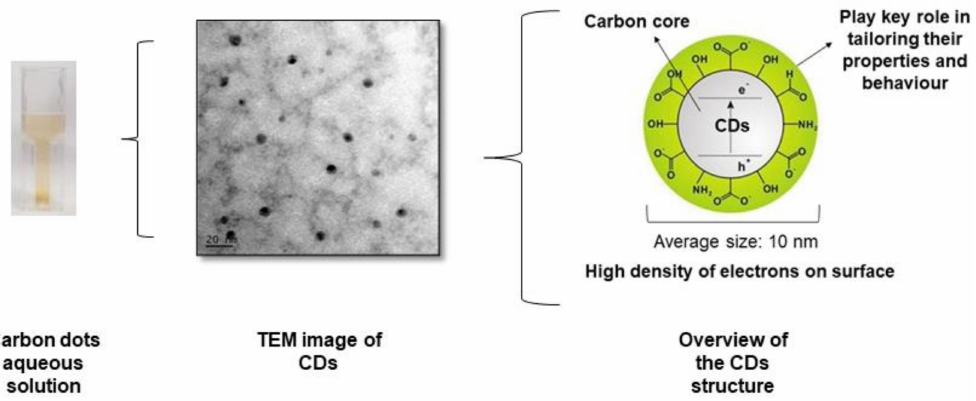
Figure 3. Carbon dots made of citric acid, urea, and iron (III) in aqueous solution, under the transmission electron microscope, and a schematic illustration of their